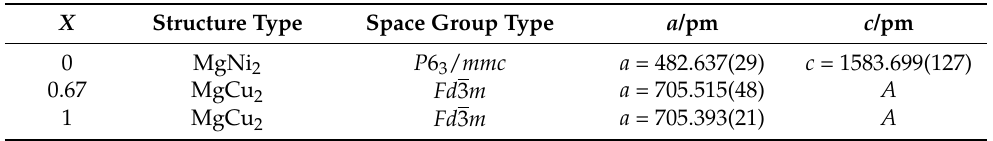
Figure 3. Rietveld refinement of ( a ) Ca x Mg 1 − x Ni 2 ( x = 1) R w p = 3.36%, χ ² = 1.50, ( b ) Ca x Mg 1 − x Ni 2 ( x = 0.67) R w p = 2.46%, χ ² = 1.05, ( c ) Ca x Mg 1 − x Ni 2 ( x = 0) R w p = 4.70%, χ ² = 1.60; after hydrogenation in autoclave based on X-ray powder diffraction at 297(1) K (Mo K α 1 radiation, λ = 70.926 pm (Black = observed; Red = calculated and Blue = Difference)). Table 2. Refined lattice parameters of Ca x Mg 1 − x Ni 2 ( x = 1, x = 0.67 and x = 0) compounds after hydrogenation based on X-ray powder diffraction at 297(1) K.